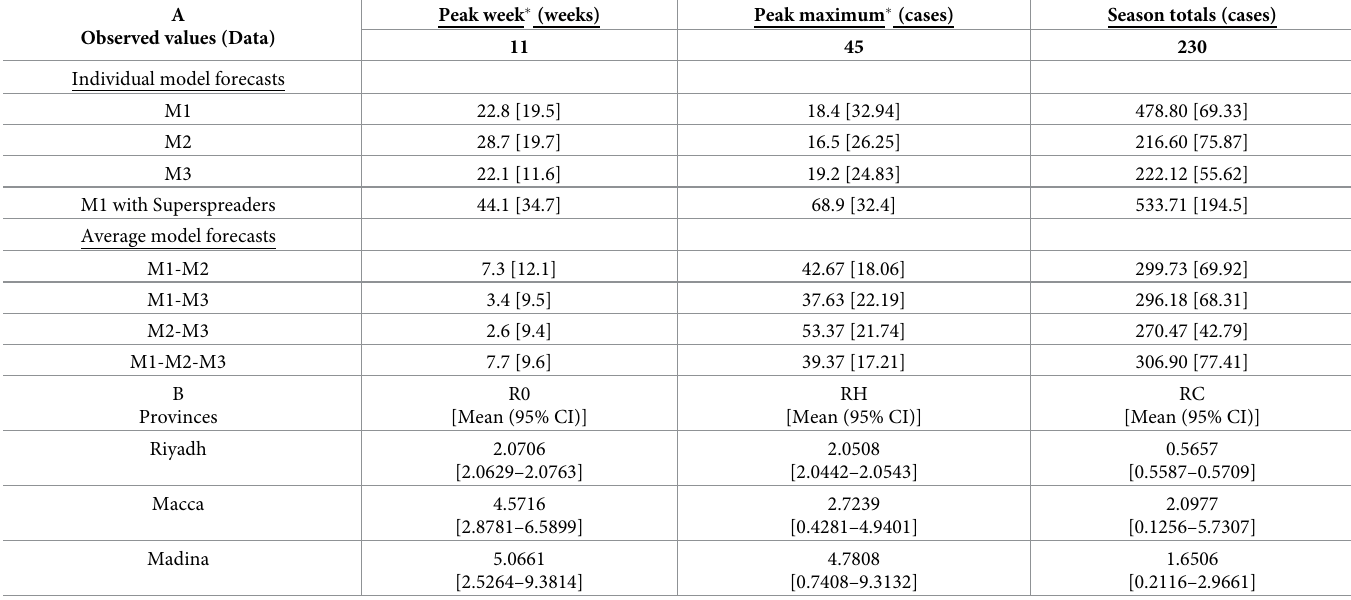
Table 2. (A)Average predictions [Simple average of Mean Absolute Errors (MAE)] over all forecasts of the three 2-strain models and their different combinations for the Riyadh province. (B)Estimated values of the Basic reproduction number (R 0 ), the Hospital reproduction number (R H ), and the Community reproduction number (R C )for the three provinces of Saudi Arabia using best model (two strain). The best two strain MERS model is with saturated incidence. The data are given as Mean (95% CI). � The MAE for the three models and their combinations during point prediction of peak week and peak incidence were calculated up-to the peak of the prediction sea- son (11th Week) of the Riyadh